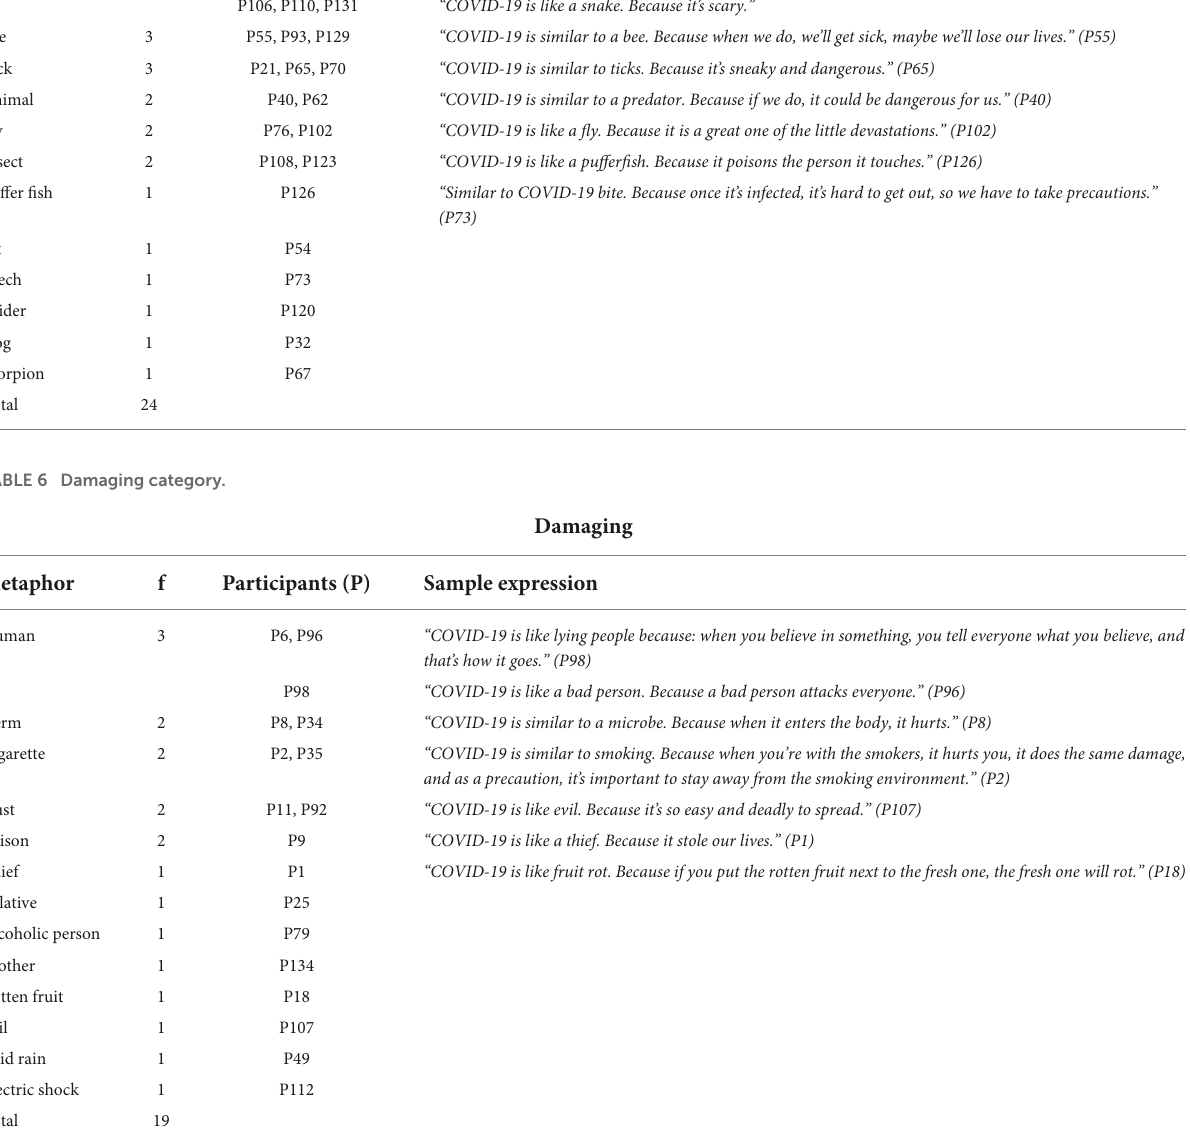
Animal Sample expressions